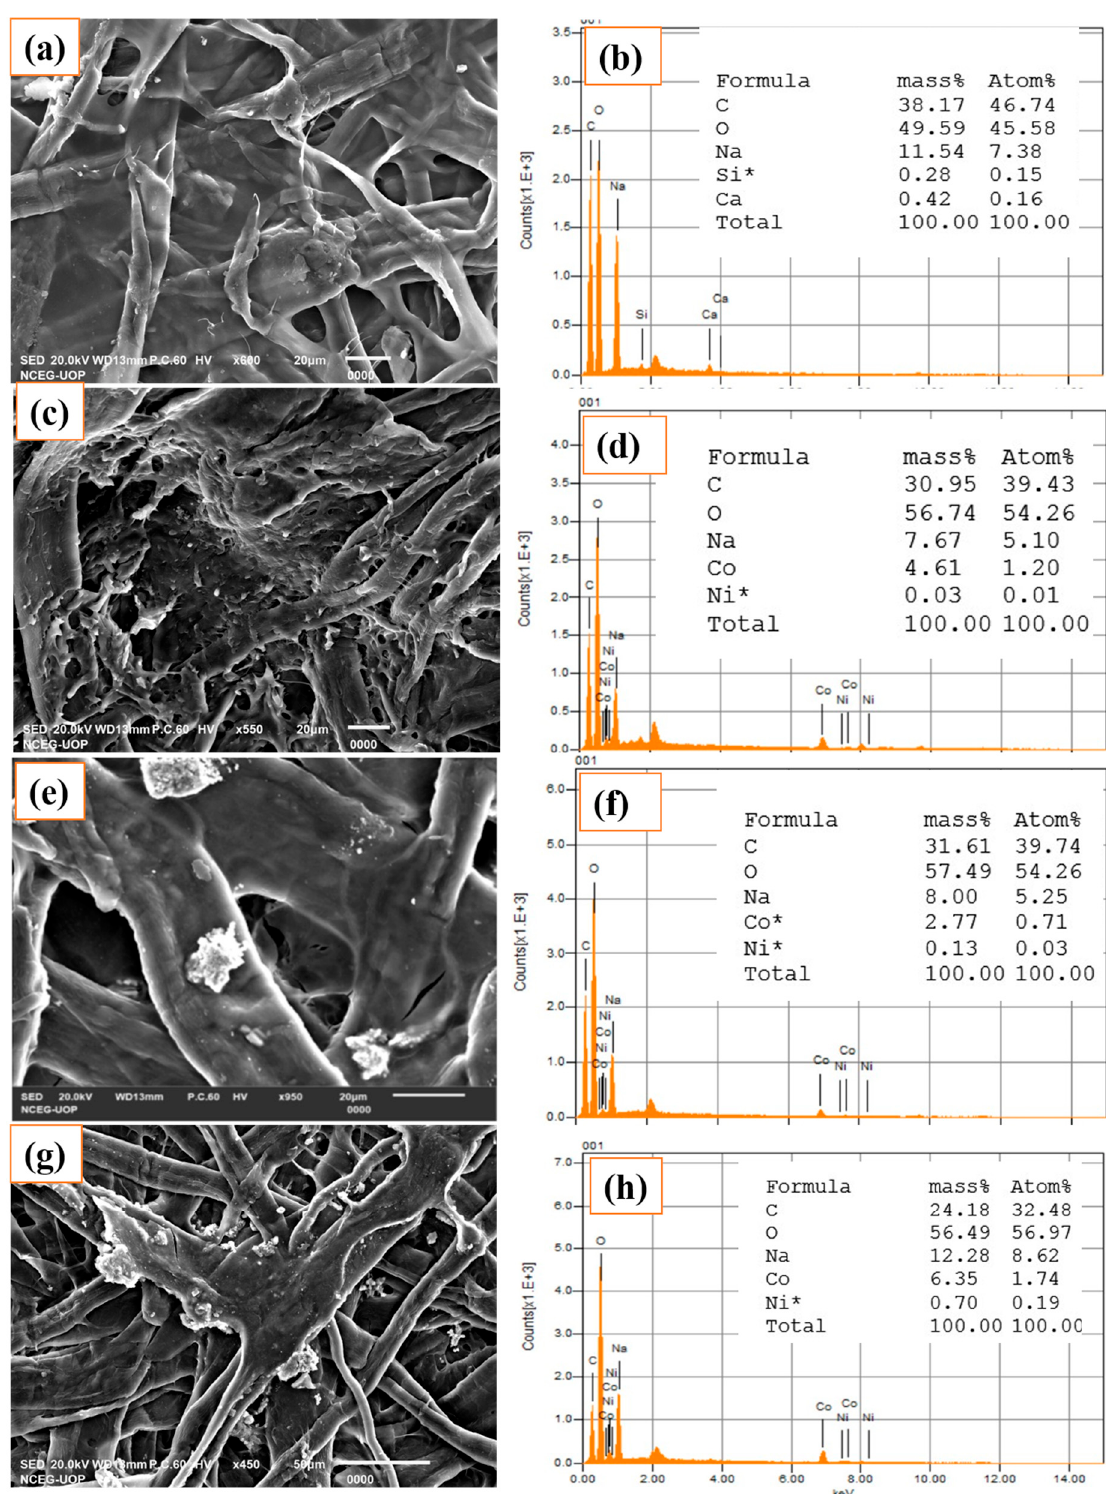
Figure 1. The left-hand side are the FESEM images that give the right-hand side elemental window with their mass and atomic percentage. The FESEM and EDS images of Alg/FP ( a , b ), Alg/FP@Co NPs ( c , d ), Alg-CoNi1/FP@Co ( e , f ), and Alg-CoNi2/FP@Co NPs ( g , h ), respectively. The star indicated in the EDS window are the Ni and Co. The EDS vertical axes indicate the scientific notation as 1 x 10 3 .